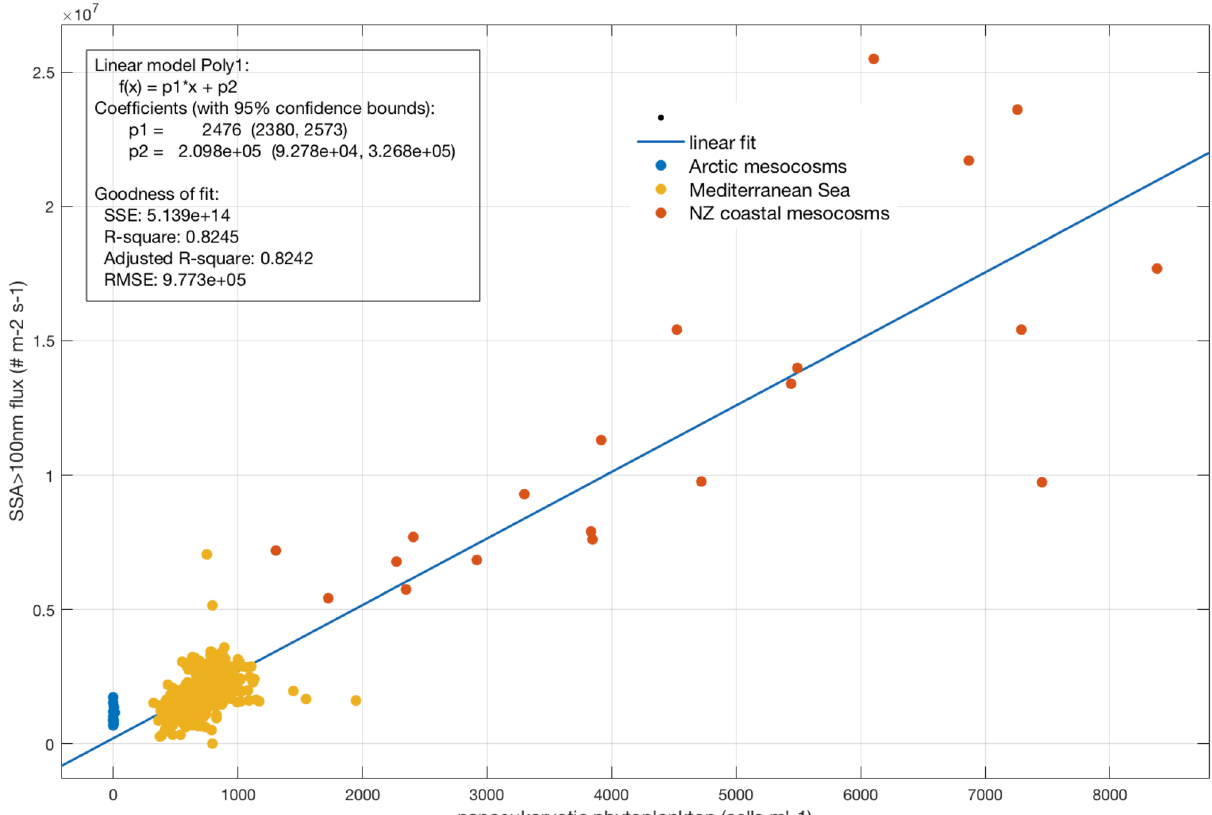
Figure 3. SSA larger than 100 nm flux number F SSA100 (# m −2 s −1 ) calculated for a wind speed of 9 m s −1 and 15 °C sea temperature as a function of the NanoPhyto (cells ml −1 ) from different regions. The solid line indicates the linear fit to the data